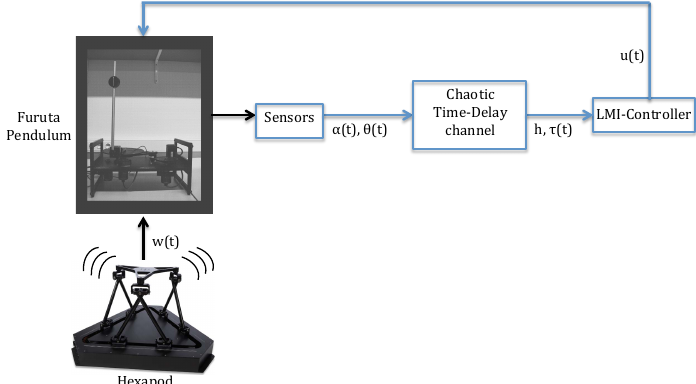
Figura 1. Hexapod comercializado por la compañía Quanser (Fuente: Quanser). Figure 2. Diagram of the perturbed random time delay